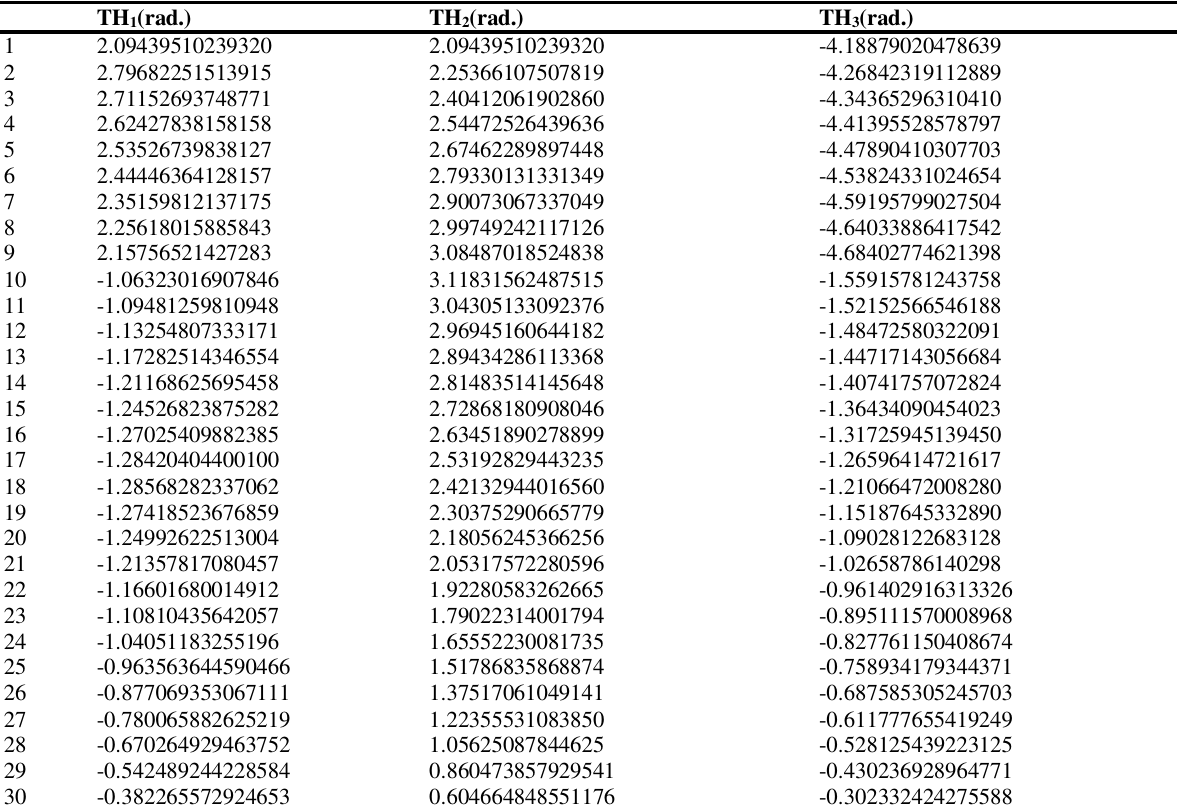
Best three joints angles results of the sinwave trajectory for three link redundant robot. TH 1 (rad.) TH 2 (rad.) TH 3